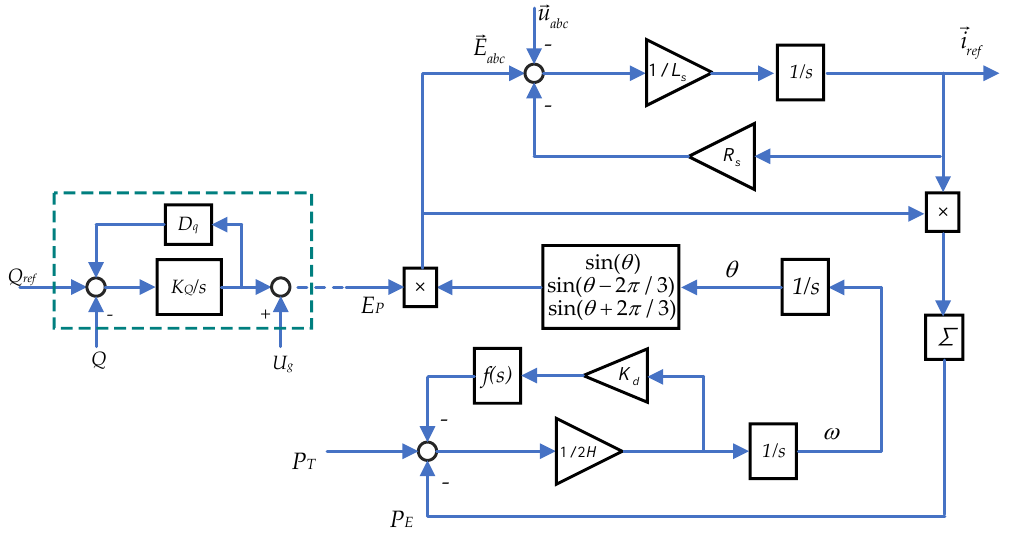
Figure 4. The control structure of VISMA.